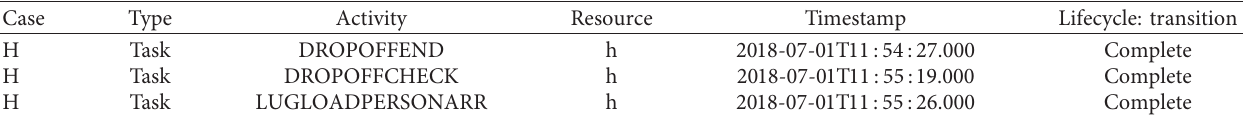
Table 4: Example log of flight service event of Xining Airport in July